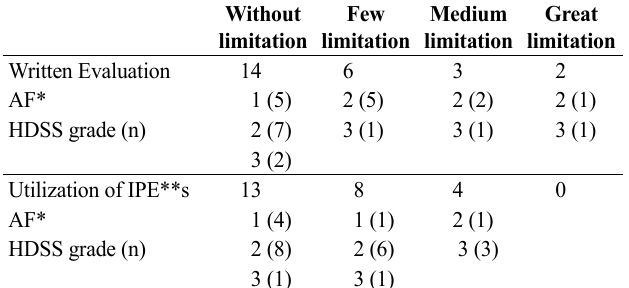
Table 2: Distribution of work-related limitations related to PH’s lev- el, reported by the 25 academics with primary hyperhidrosis of the Table 3: Analysis of the limitations in work activities reported by the